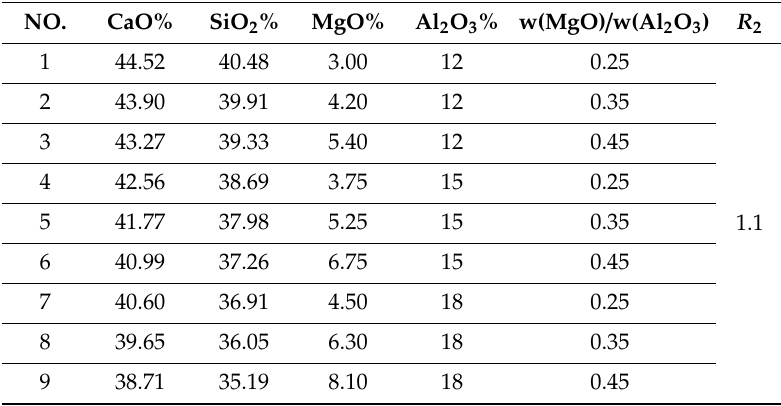
Table 1. Experimental viscosity